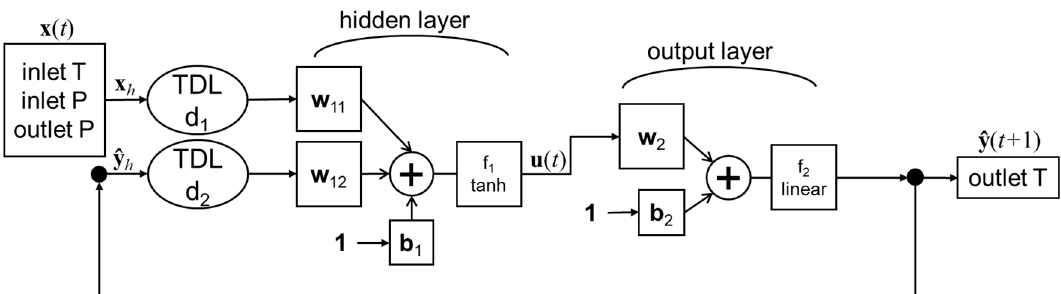
Figure 7. The NARX neural network